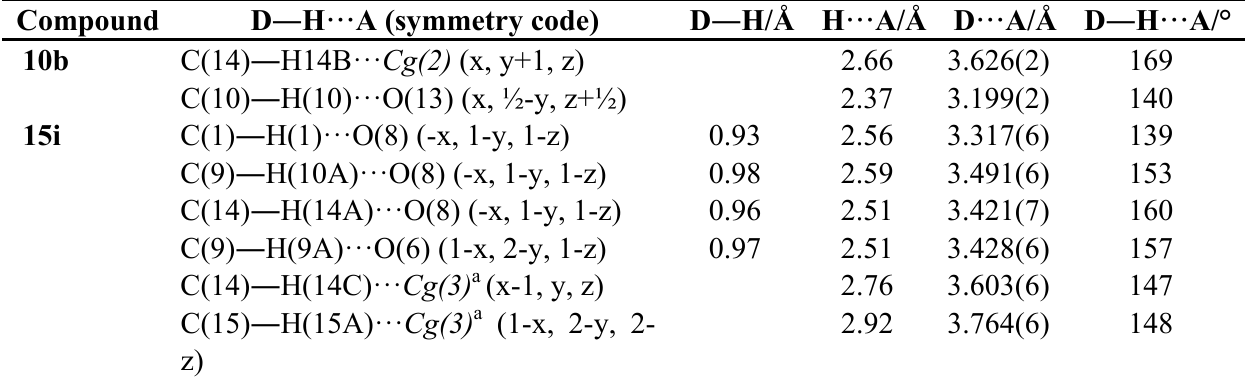
Table 2. Geometric parameters associated with intermolecular hydrogen interactions in compounds 10b and 15i